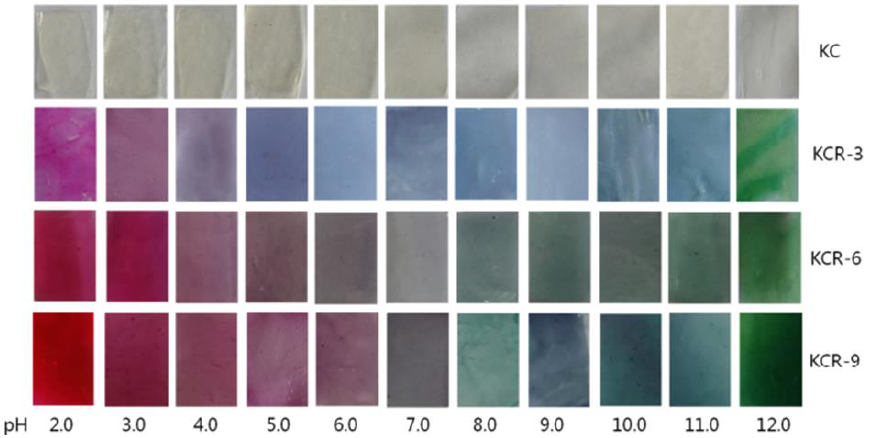
Figure 3. Color variation of composite films as exposed to different pH values (2–12) for 10 min. KC: konjac glucomannan films with oxidized chitin nanocrystals without RCA, KCR-3: film with 3% RCA, KCR-6: film with 6% RCA, and KCR-9: film with 9% RCA. Reprinted with permission from ref. [52]. Copyright 2019 Elsevier Ltd.